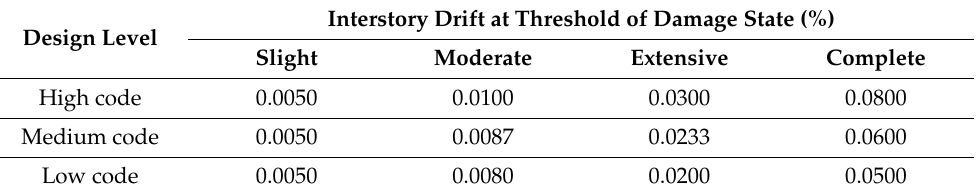
Table 1. The damage limit state of RC frame for low height building (Hazus-MH 2.1) [37].